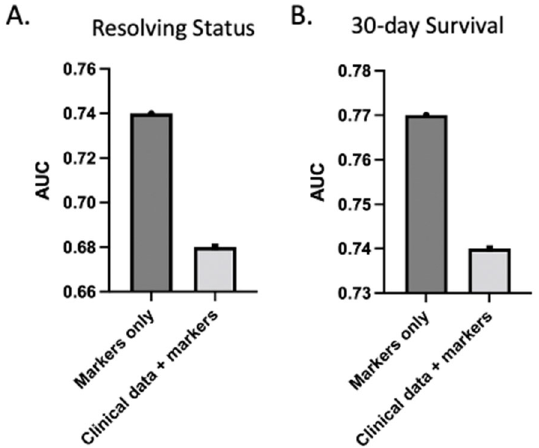
Figure 4. Clinical data do not increase AUC of predictive models. AUC of LASSO model with both clinical variables and markers decreased relative to model with markers alone for both resolving status ( A ) and 30 ‐ day survival ( B ). Clinical variables include admission ISS, age, BMI, systolic blood pressure, diastolic blood pressure, mean arterial pressure, heart rate, shock index, lactate, and bicarbonate levels.